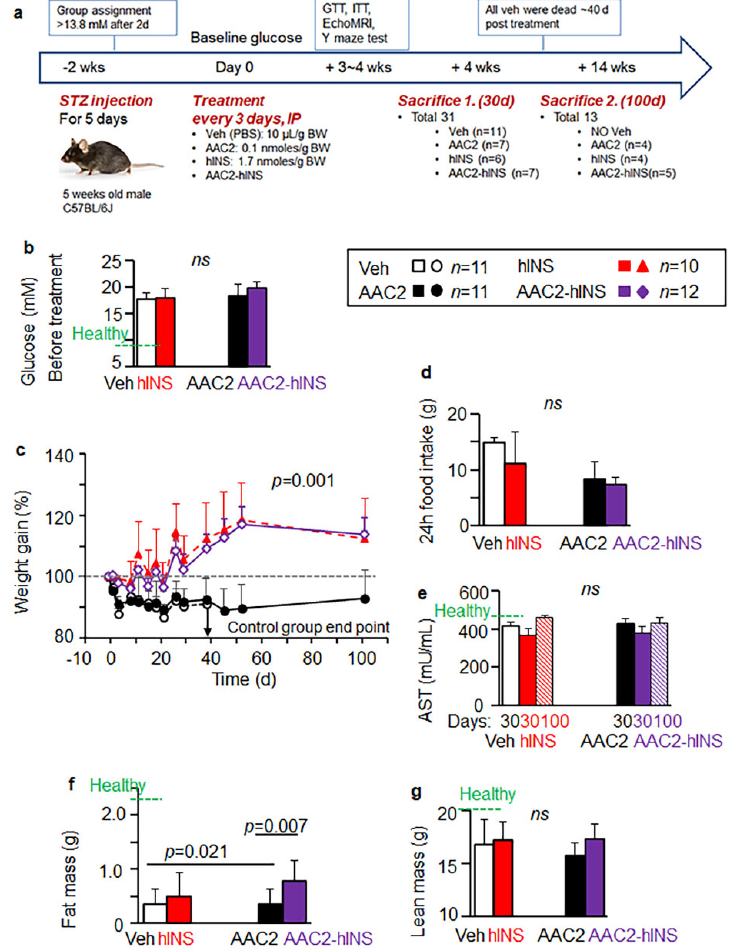
Figure 4. Improved body composition in AAC2-hINS-treated mice with STZ-induced T1D. ( a ) Schematic presentation of induction of experimental T1D by streptozotocin (STZ mice, total n = 44 mice) and treatment protocol of control group with vehicle, AAC2, hINS, AAC2-hINS complex. Treatments were administered intraperitoneally (i.p.) every 3 days. After starting treatments, mice died or were sacrificed prior to the death (30 days group). The surviving mice continued with treatments for 100 days. ( b ) Glucose levels (mM) in STZ-induced mice groups prior to the treatment. One-way ANOVA. p = 0.157; not significant, ns. Green dashed line-the fasting glucose levels in healthy mice. ( c ) Weight gain of the STZ mice was measured until they succumbed to the diseased ( n = 7) or were sacrificed. Data are shown as % of baseline body weight of each animal before induction of T1D (100%, gray dash line). Overall comparison p = 0.001 (Kruskal–Wallis test with a Mann–Whitney U-test for post hoc testing). For ( d ) Food intake was collected for 24 h on multiple days. ( e ) Plasma aspartate aminotransferase (AST) levels in plasma of the STZ mice were measured after 30 days and 100 days post treatment. One-way ANOVA. ns, not significant. Green dashed line-the AST levels in healthy mice ( n = 6). ( f , g ) Fat ( f ) and lean ( g ) body mass of the STZ mice and healthy mice (dashed line, n = 6) were measured using Echo-MRI 3 weeks after. p = 0.043 for overall comparison of fat body mass. ns,